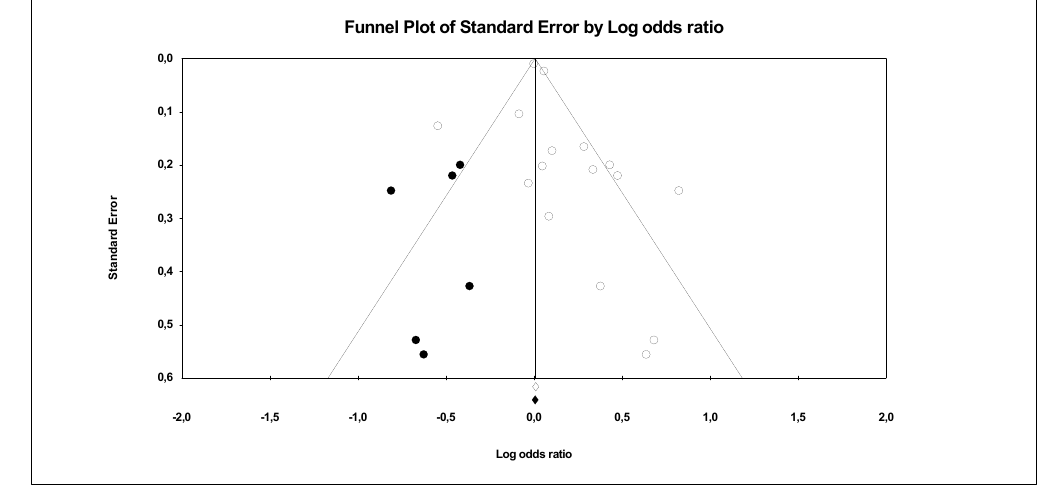
Figure 9. Funnel plots of observational studies of the association of PFOA exposure with CVDs and their risk factors . The publication bias is adjusted by imputing the missing studies based on the asymmetry of the funnel plot. ( ● ) Plot Imputed and ( ○ ) Plot observed studies. Egger’s linear regression test (Intercept 0.84, t = 1.66, p = 0.12). Adjusted values ‘Trim and Fill’ test (1.00, CI = 0.91, 1.10).